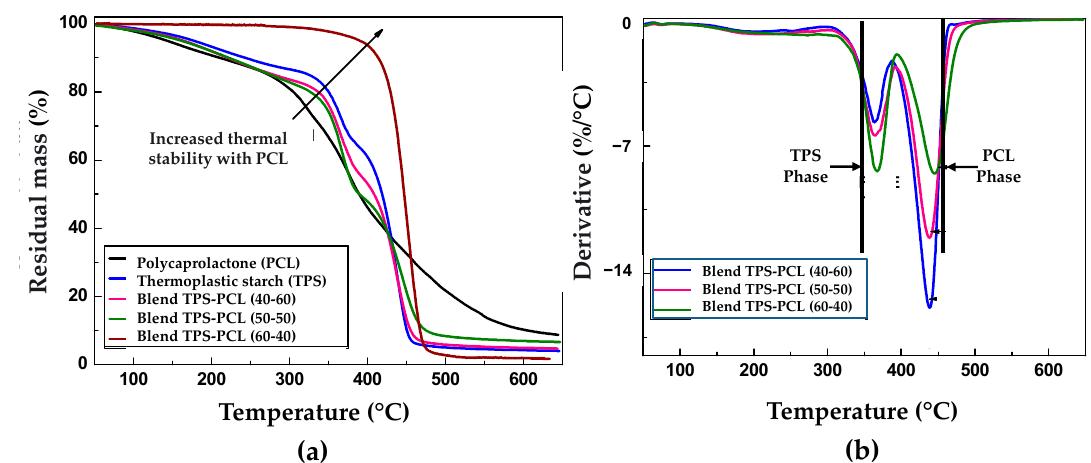
Figure 6. Thermogravimetric (TG) curves for ( a ) neat PCL, neat TPS, and binary blends TPS/PCL. DTG curves for ( b ) binary blends TPS/PCL.